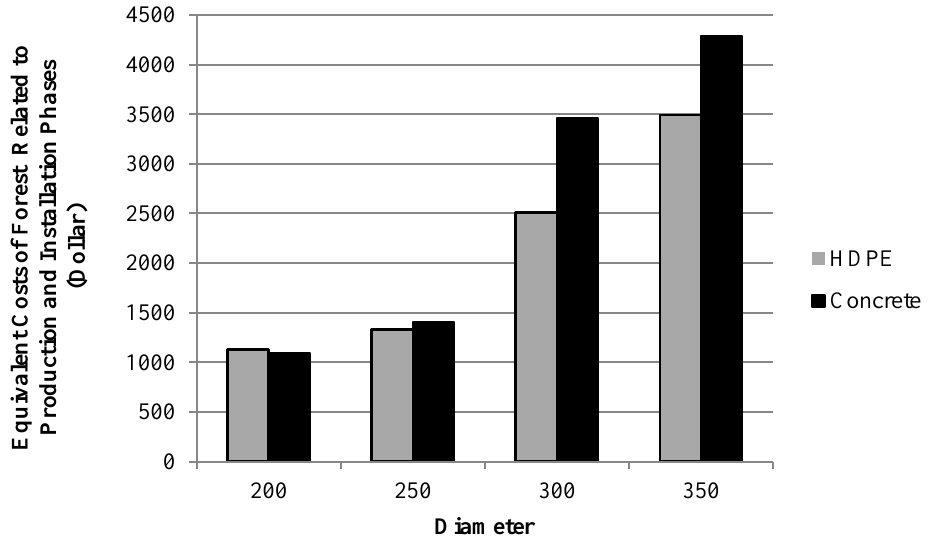
Fig. 5. The equivalent costs of forest for sequestering CO 2 emissions related to the production and installation phases